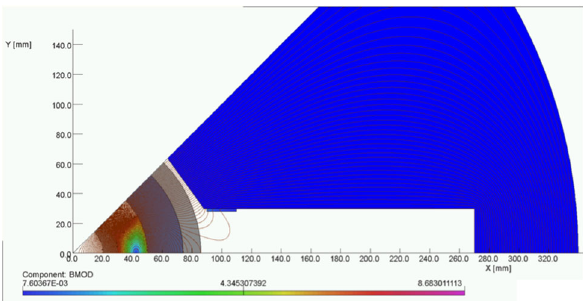
Fig. 13 Layout of the first proton quadrupole after beam separation.